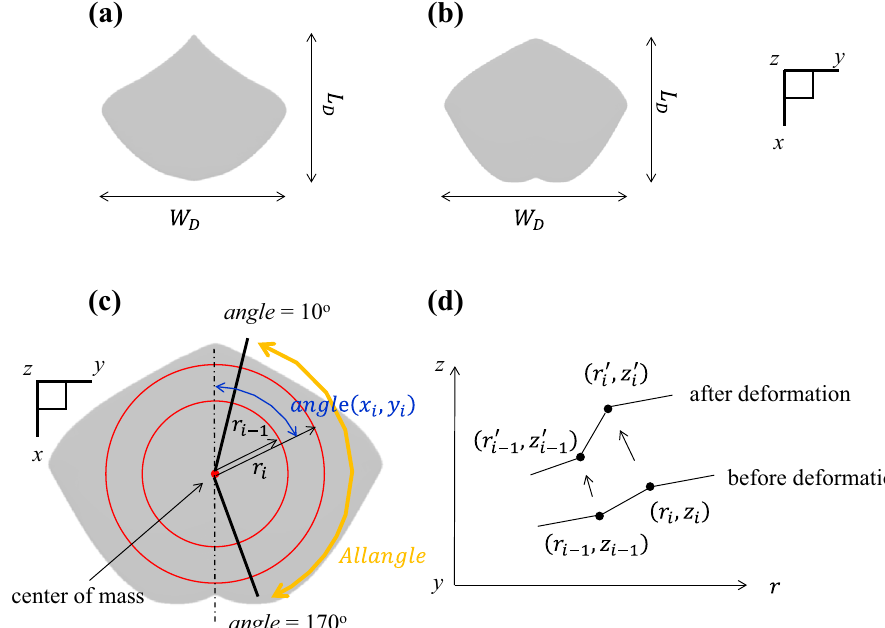
Figure 1. Analytical targets and description of motion. ( a ) Analytical model of D. acutirostra. ( b ) Analytical model of D. matsubarai. ( c ) Description of motion, ( d ) the relationship between any two points on the surface before and after the